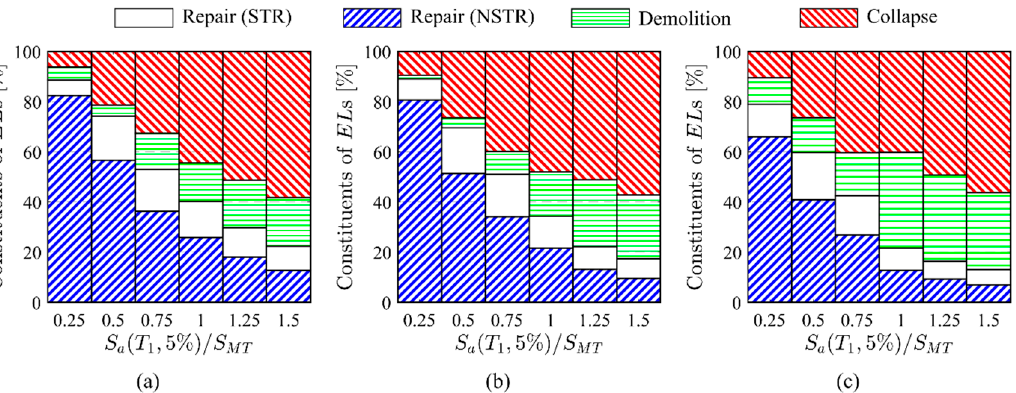
Figure 13. Composition ratio of repair, demolition, and collapse for EL of 15-story steel OMFs: ( a ) W0-OMF; ( b ) W44-OMF; ( c ) W51-OMF.